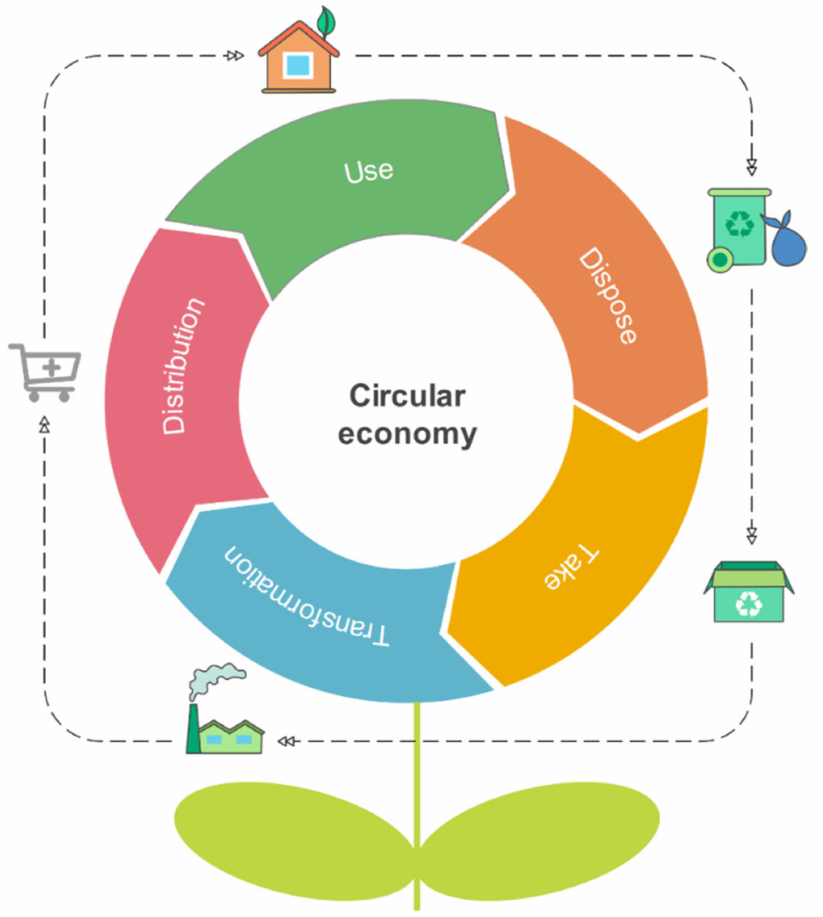
Figure 3. Scheme for a circular economy